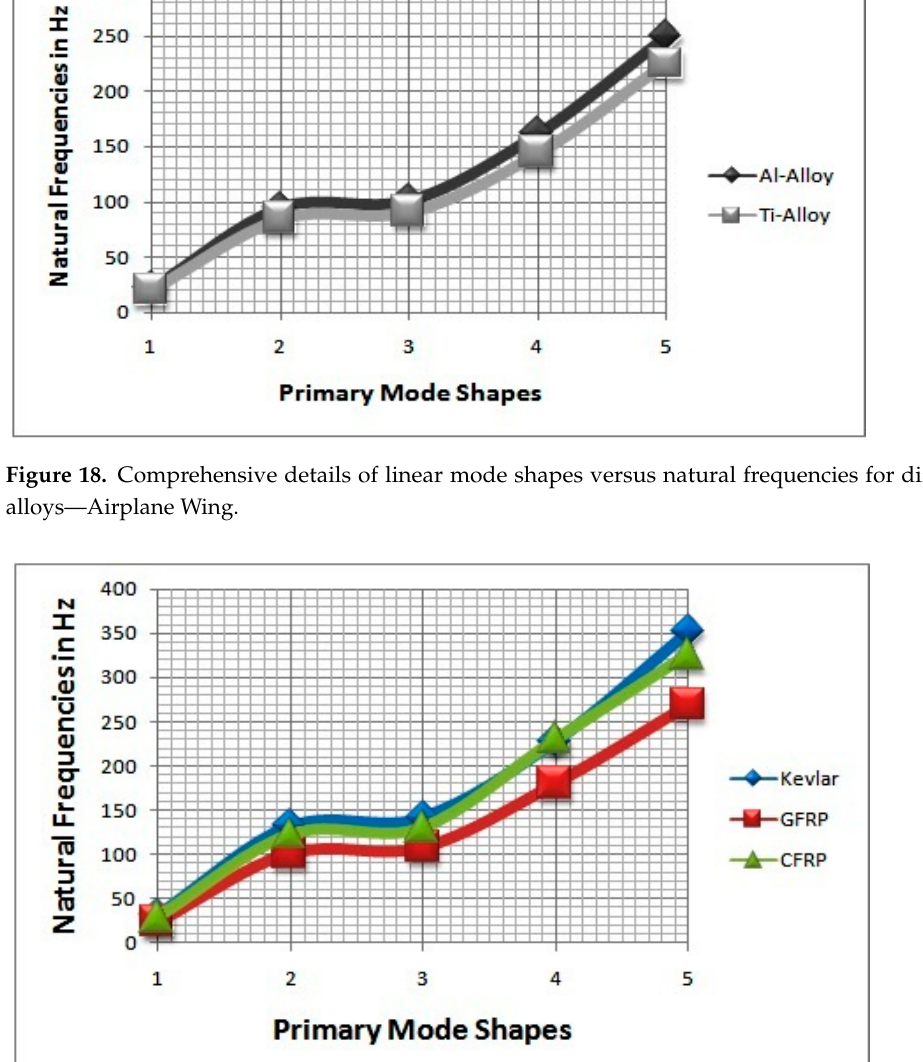
Figure 19. Comprehensive details of linear mode shapes versus natural frequencies for different composites—Airplane Wing.